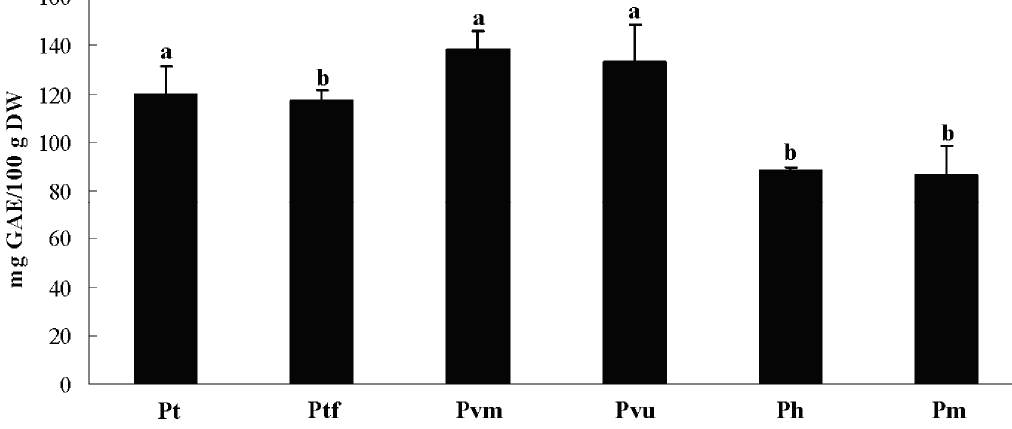
Figure 1. Total phenolics content of six Pinus tax extracts. Means with different letters indicate significant differences at the 0.05 level. Taxon codes are identified in Table